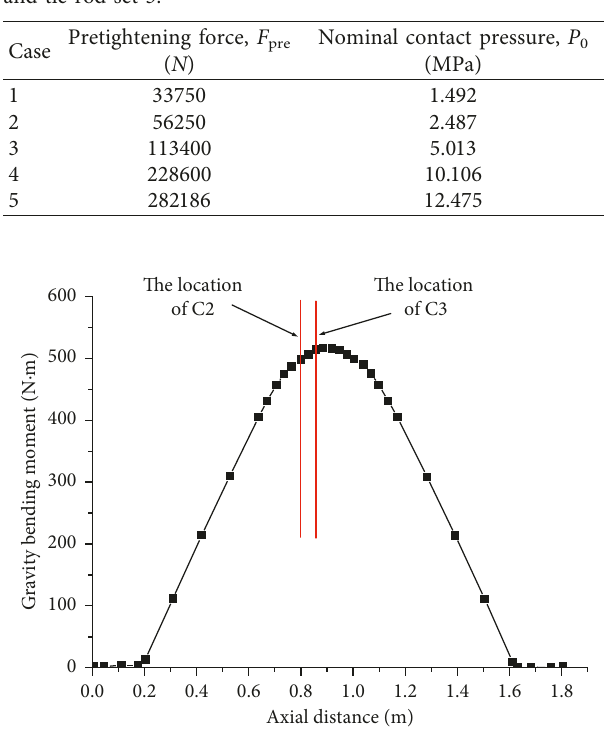
Figure 11: Distribution of the gravity bending moment of the experimental rod-fastened rotor.